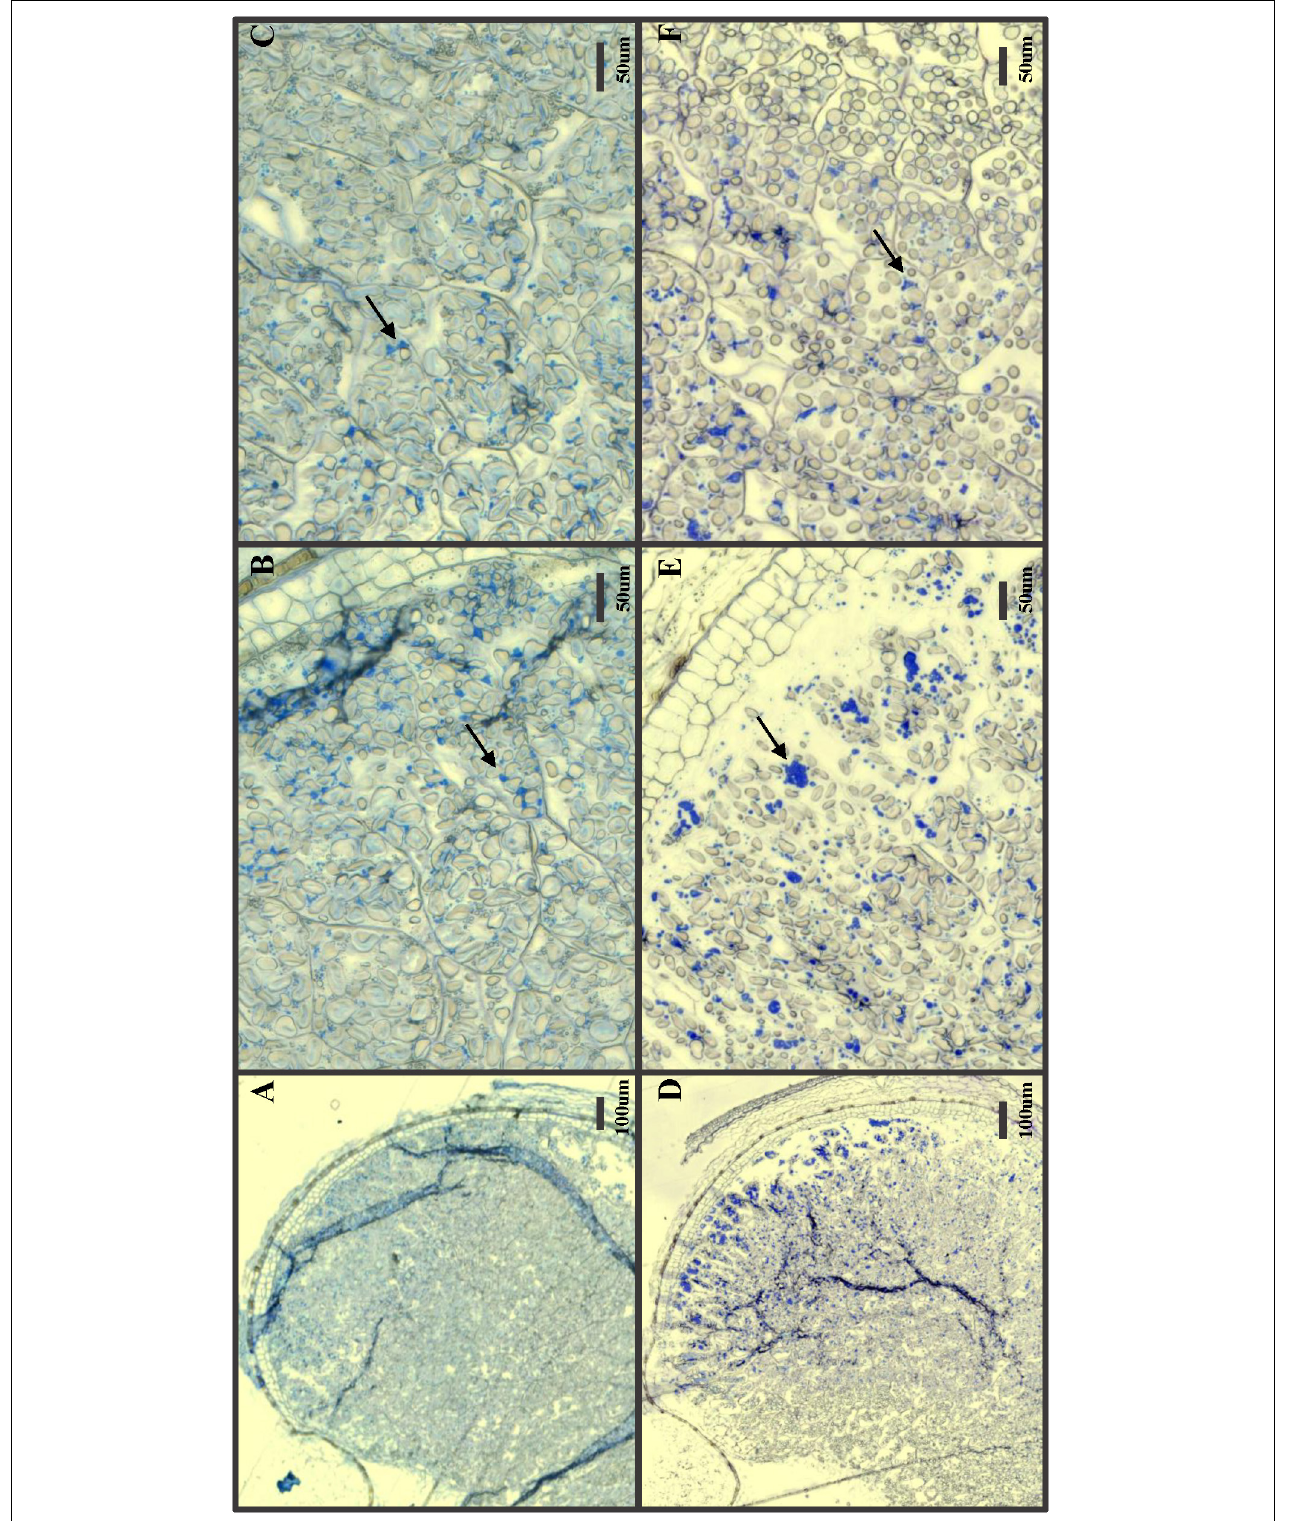
FIGURE 3 | Protein stain of developing seeds 20 days after pollination. (A–C) GP pdi ; (D–F) Golden Promise. (A,D) Zoomed out picture with the endosperm and aleurone layer. (B,E) Zoomed view of outer are including the aleurone layer. (C,F) Zoomed view of inner part of endosperm. Arrows: Protein bodies. Size bars with length indicated in µ